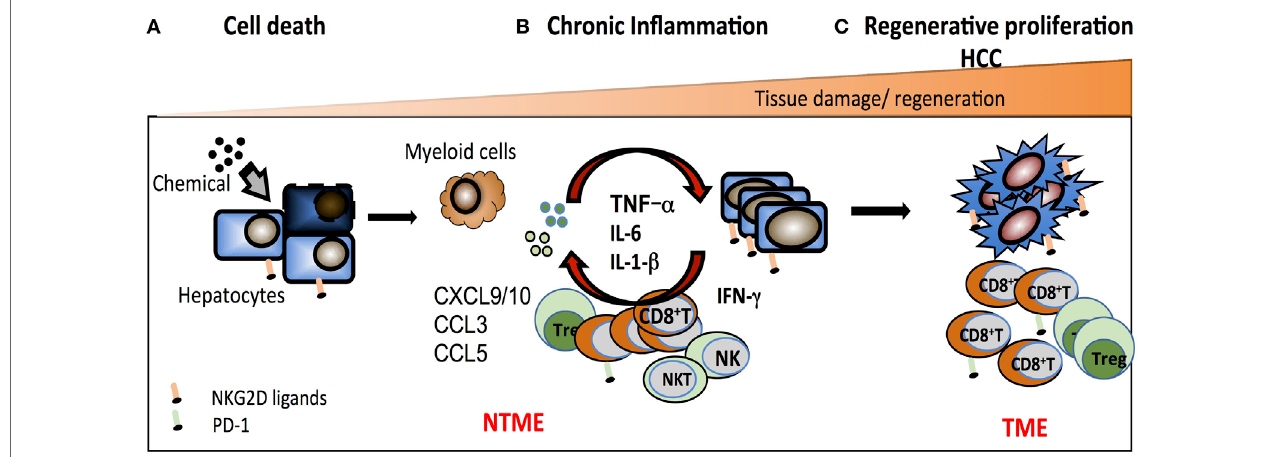
FiGUre 3 | Working model of the pro-tumorigenic effect of NKG2D in hepatocellular carcinoma. (a) Chemical and/or viral injury causes cell stress that results in DNA damage, increased expression of NKG2D ligands, and hepatocyte cell death. NKG2D + -resident effector cells [natural killer (NK) cell, NKT cell, CD8 + T cells] participate in the elimination of stressed hepatocytes and contribute to shaping an innate inflammatory environment that further drives the recruitment and activation of antigen-specific CD8 + T cells. (B) In response to a continuous exposure to NKG2D ligands in the non-tumor microenvironment (NTME), NKG2D + effector cells exacerbate the local inflammation via direct secretion of inflammatory components (such as TNF α , IFN γ , and MIP1- α ) and chemoattractants leading to an enrichment in CD8 + T cells. This indirectly favors the recruitment of myeloid cells that further the inflammatory milieu with pro-inflammatory cytokines such as IL-6, TNF α , and IL-1 α . (C) In this context, cycles of persistent tissue injury characterized by the death of hepatocytes consequently drives the process of tissue regeneration, which encompass the proliferation of mutated hepatocytes or epithelial cells and ultimately promotes tumor growth. In the TME, the majority of CD8 + T cells expresses PD-1 and may become partially impaired in their antitumor function due to antigen-specific chronic